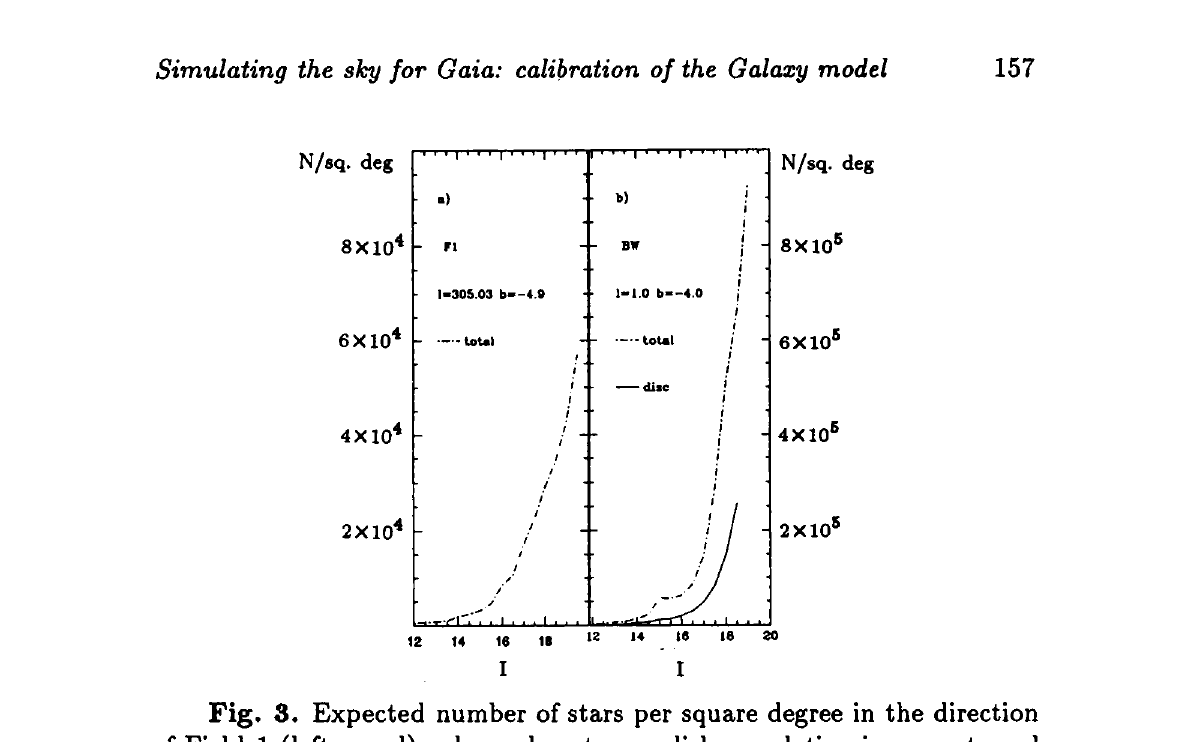
Fig. 3. Expected number of stars per square degree in the direction of Field 1 (left panel), where almost pure disk population is present, and Baade's Window (right panel), where the mixture of disk and bulge stars is observed.